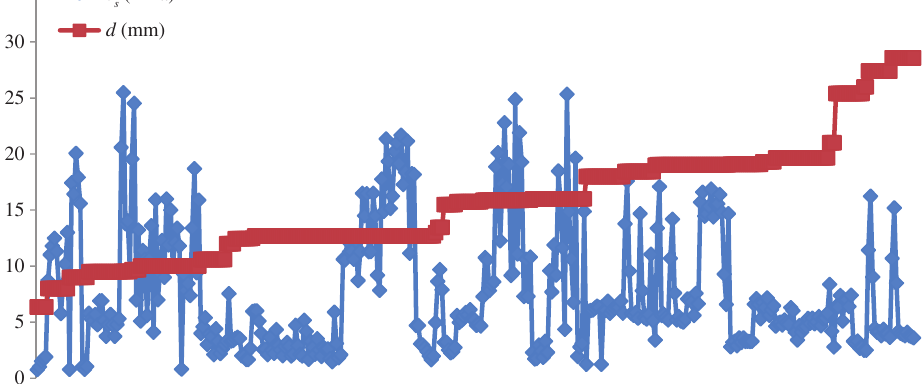
Figure 20: Change in the bond strength of FRP bars in concrete with changing diameter of